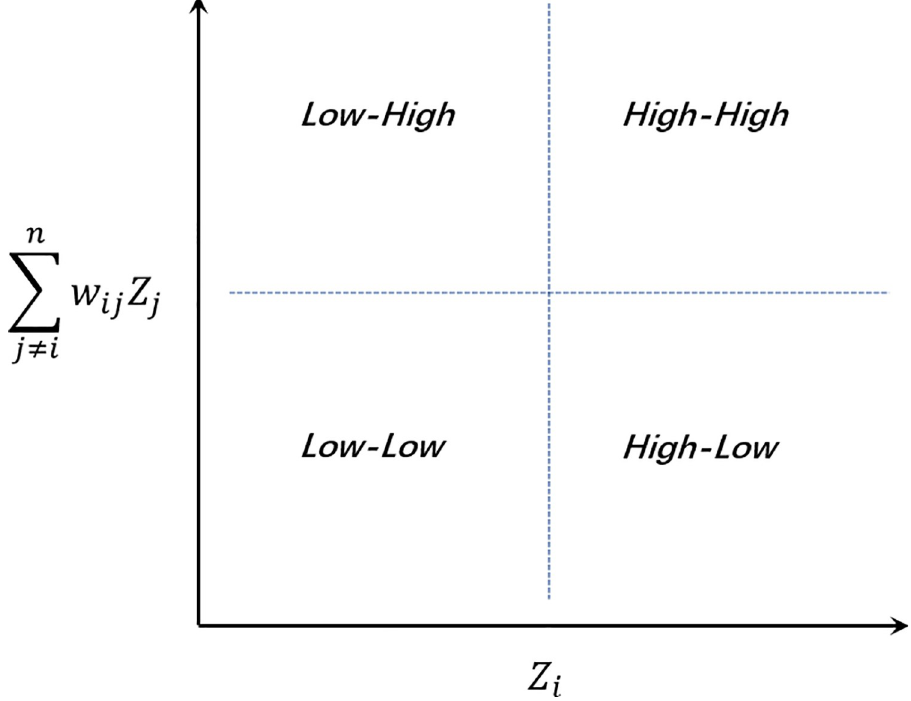
Fig 4. Local Moran’s I limit